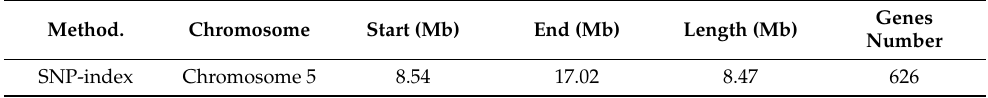
Table 1. Summary of sequencing data of BSA-seq.